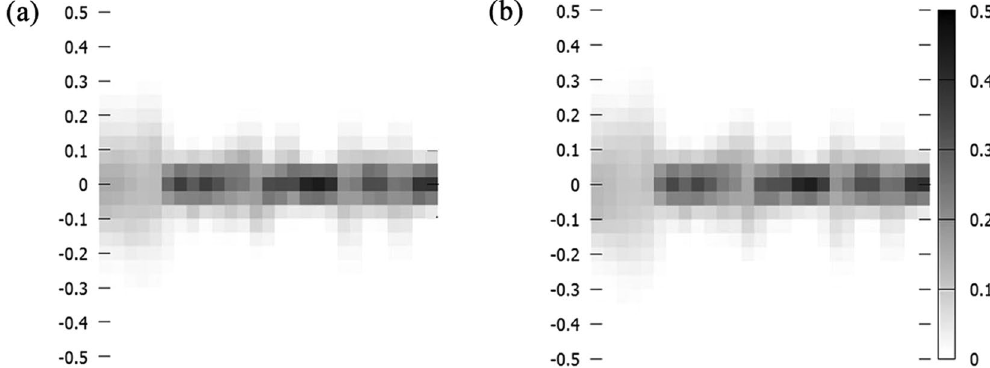
Figure 7. Partial charge deviation between PEM and DFT/TDDFT calculations for ground state ( a ) and excited state ( b ), respectively. X axis is the atom index for SA